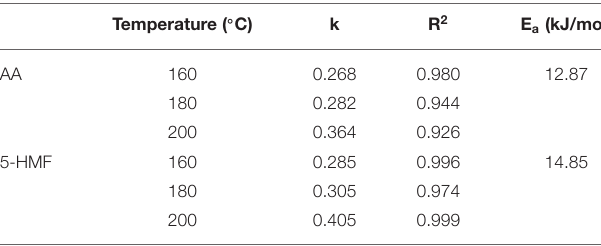
TABLE 3 | Parameter of kinetics of AA and 5-HMF in heated model